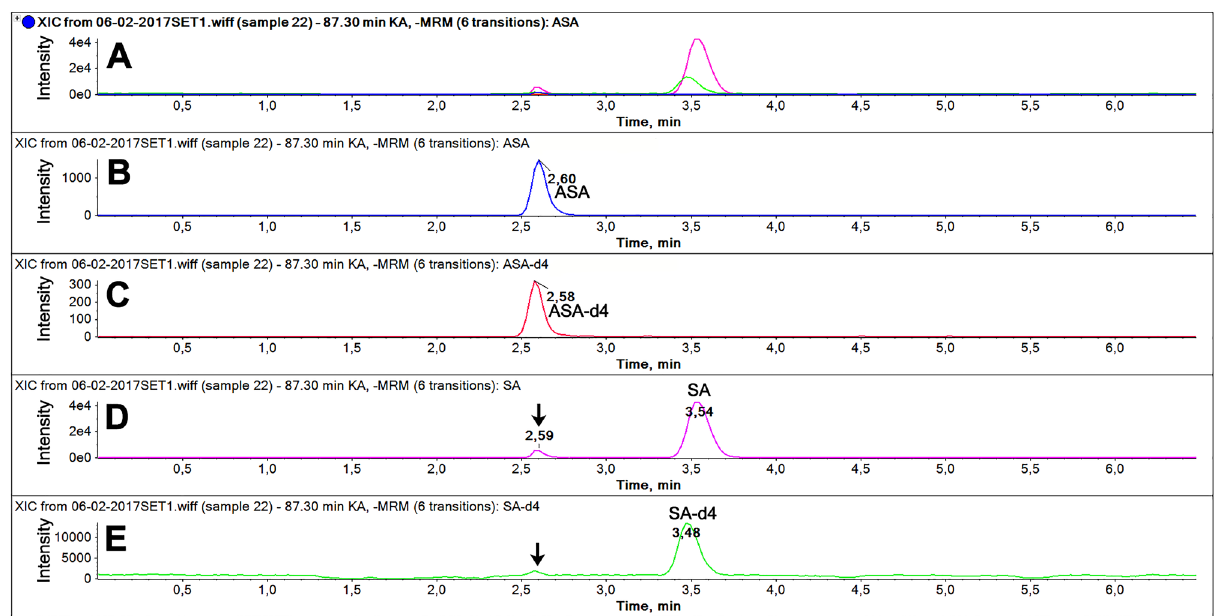
Figure 1. ( A ) extracted ion (XIC) chromatograms of all components in a plasma sample; ( B ) XIC of ASA; ( C ) XIC of ASA-d4; ( D ) XIC of SA; ( E ) XIC of SA-d4. Arrows indicate the chromatographic peaks of SA in-source generated from ASA and ASA-d4,